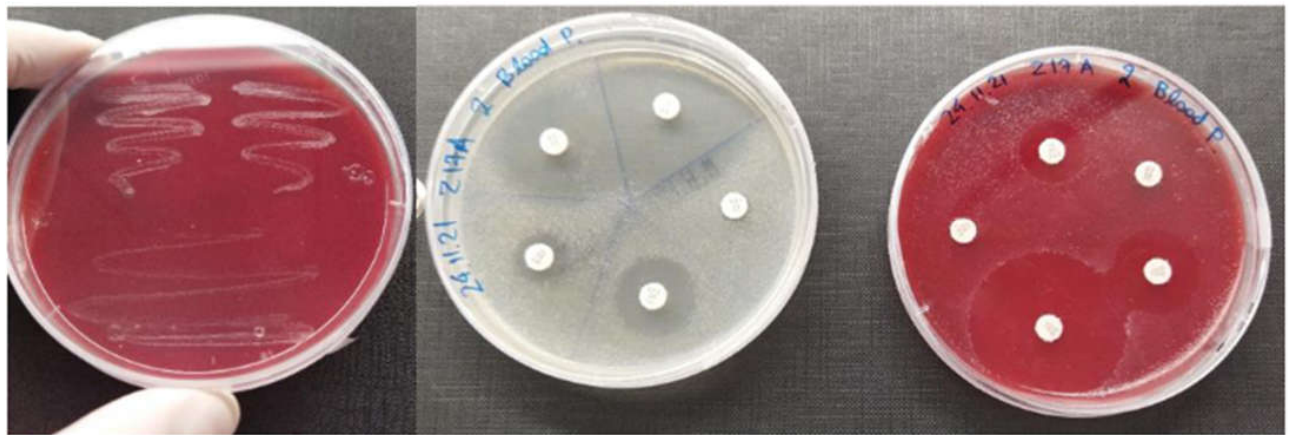
Figure 1. Culture of P. damselae sbsp . piscicida strain in blood agar plate ( uppe r). Picture of an anti- biogram in Mueller Hinton ( lower, left ) and blood agar plate ( lower, right ).